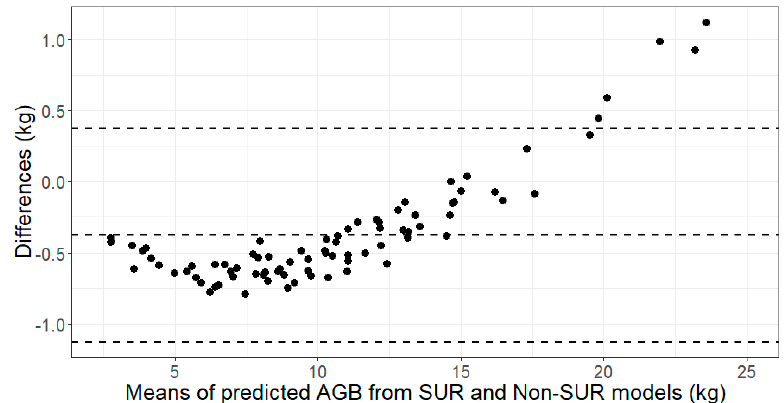
Figure 6. Bland- Altman plot: differences vs. means of predicted AGB from SUR and non-SUR models.